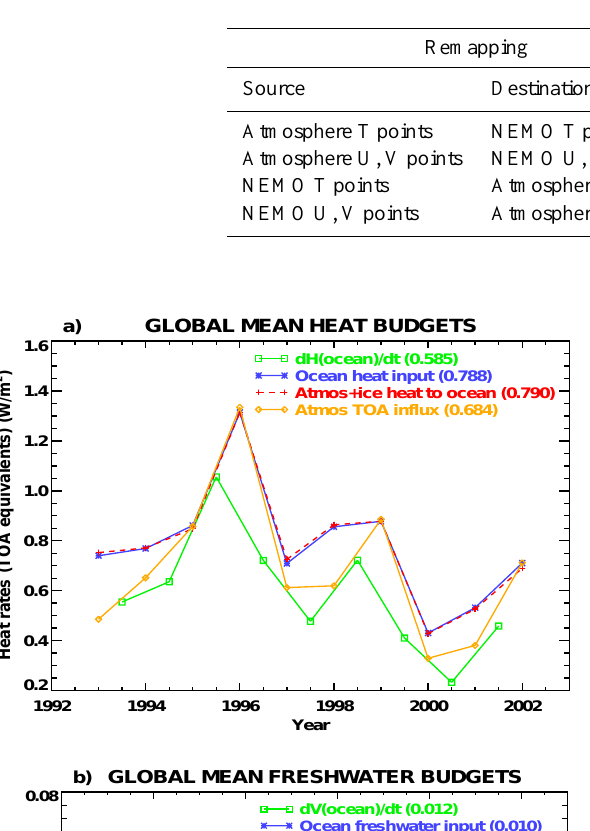
Table 3. HadGEM3 interpolation method choices.